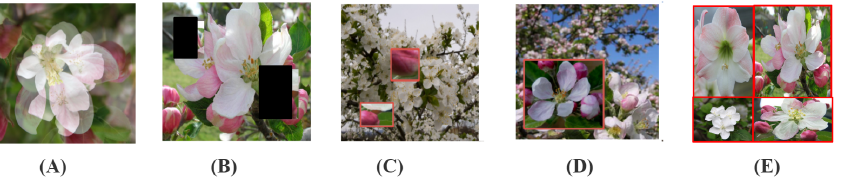
Figure 4. Illustration of five augmentation methods. ( A ) Mixup; ( B ) Cutout; ( C ) CutMix; ( D ) SnapMix; ( E ) Mosaic.